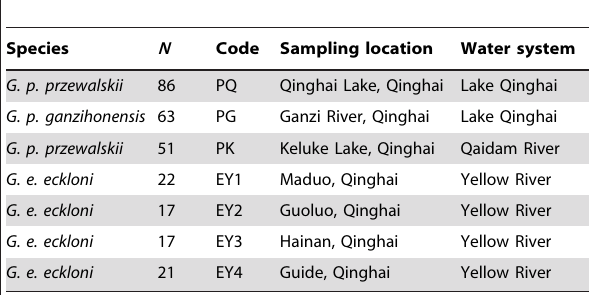
Table 1. Sampling locations, sample sizes ( N ) and water systems for each taxon in this